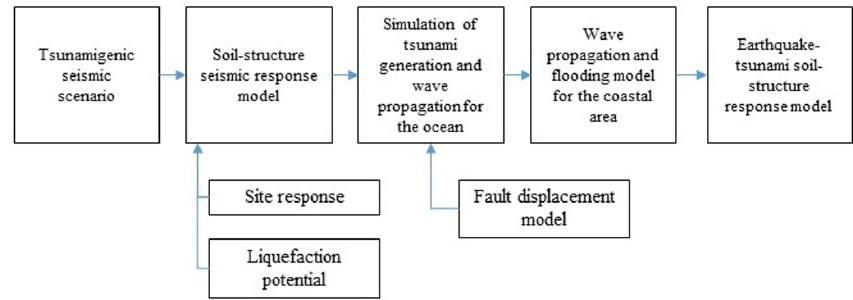
Figure 1. Evaluation of the sequential earthquake–tsunami effects on transportation infrastructure.